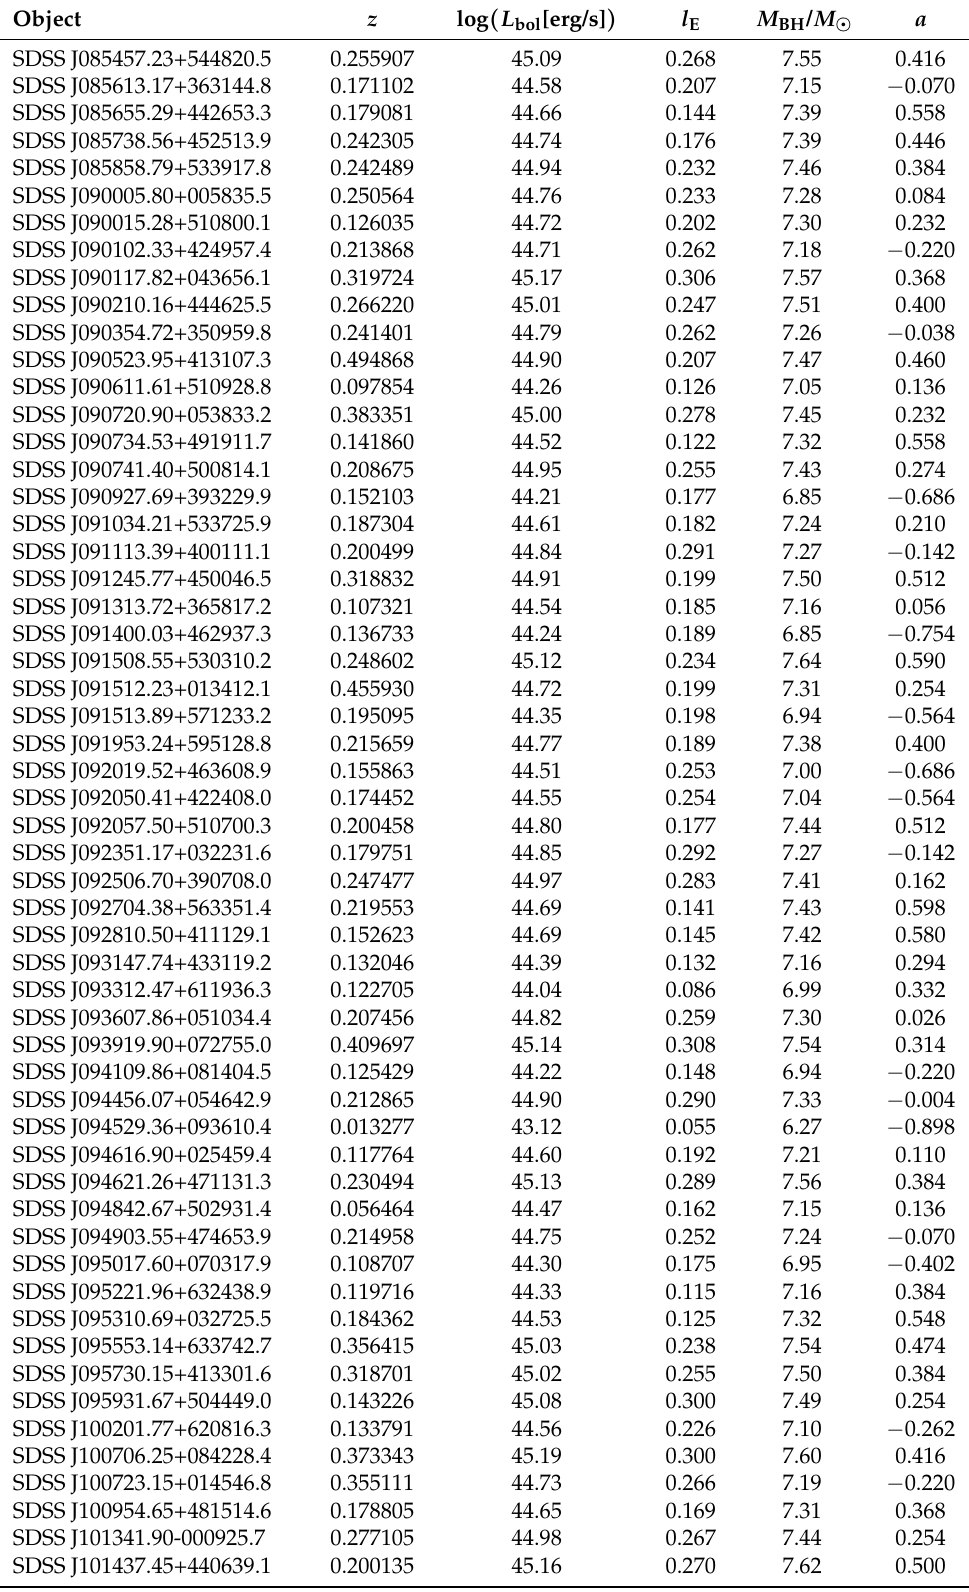
Table A3. All objects with their estimated spin values. Part 3 of